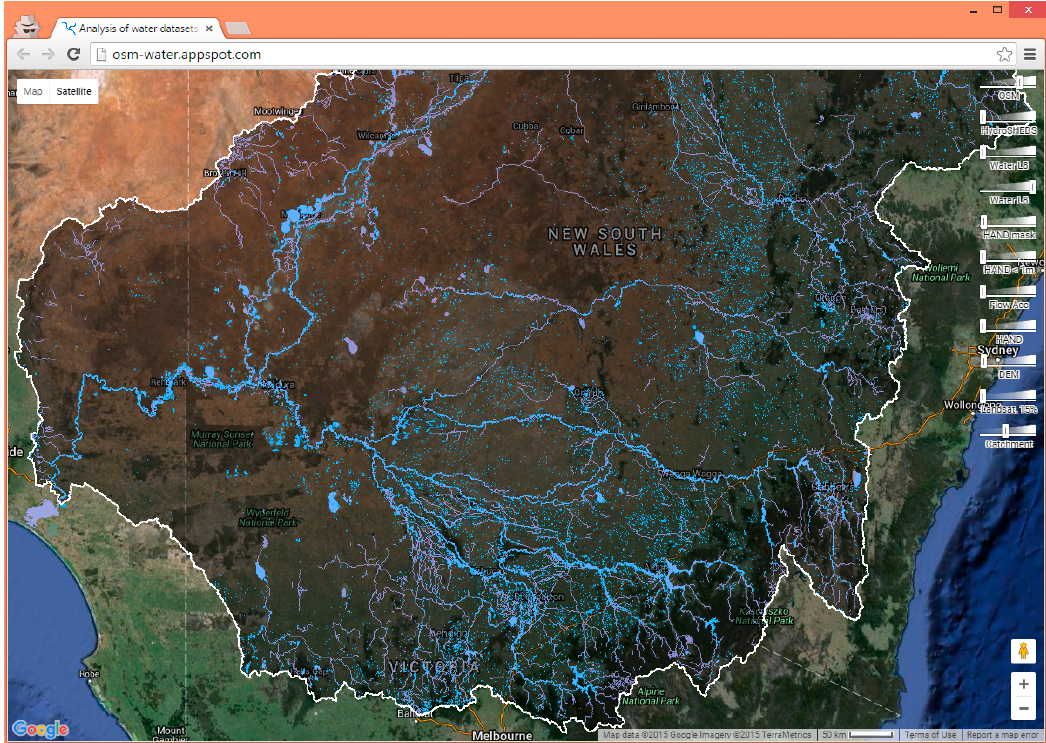
Figure A2. A screenshot of the website demonstrating the water mask derived from Landsat 8, OpenStreetMap, and 30 m SRTM.